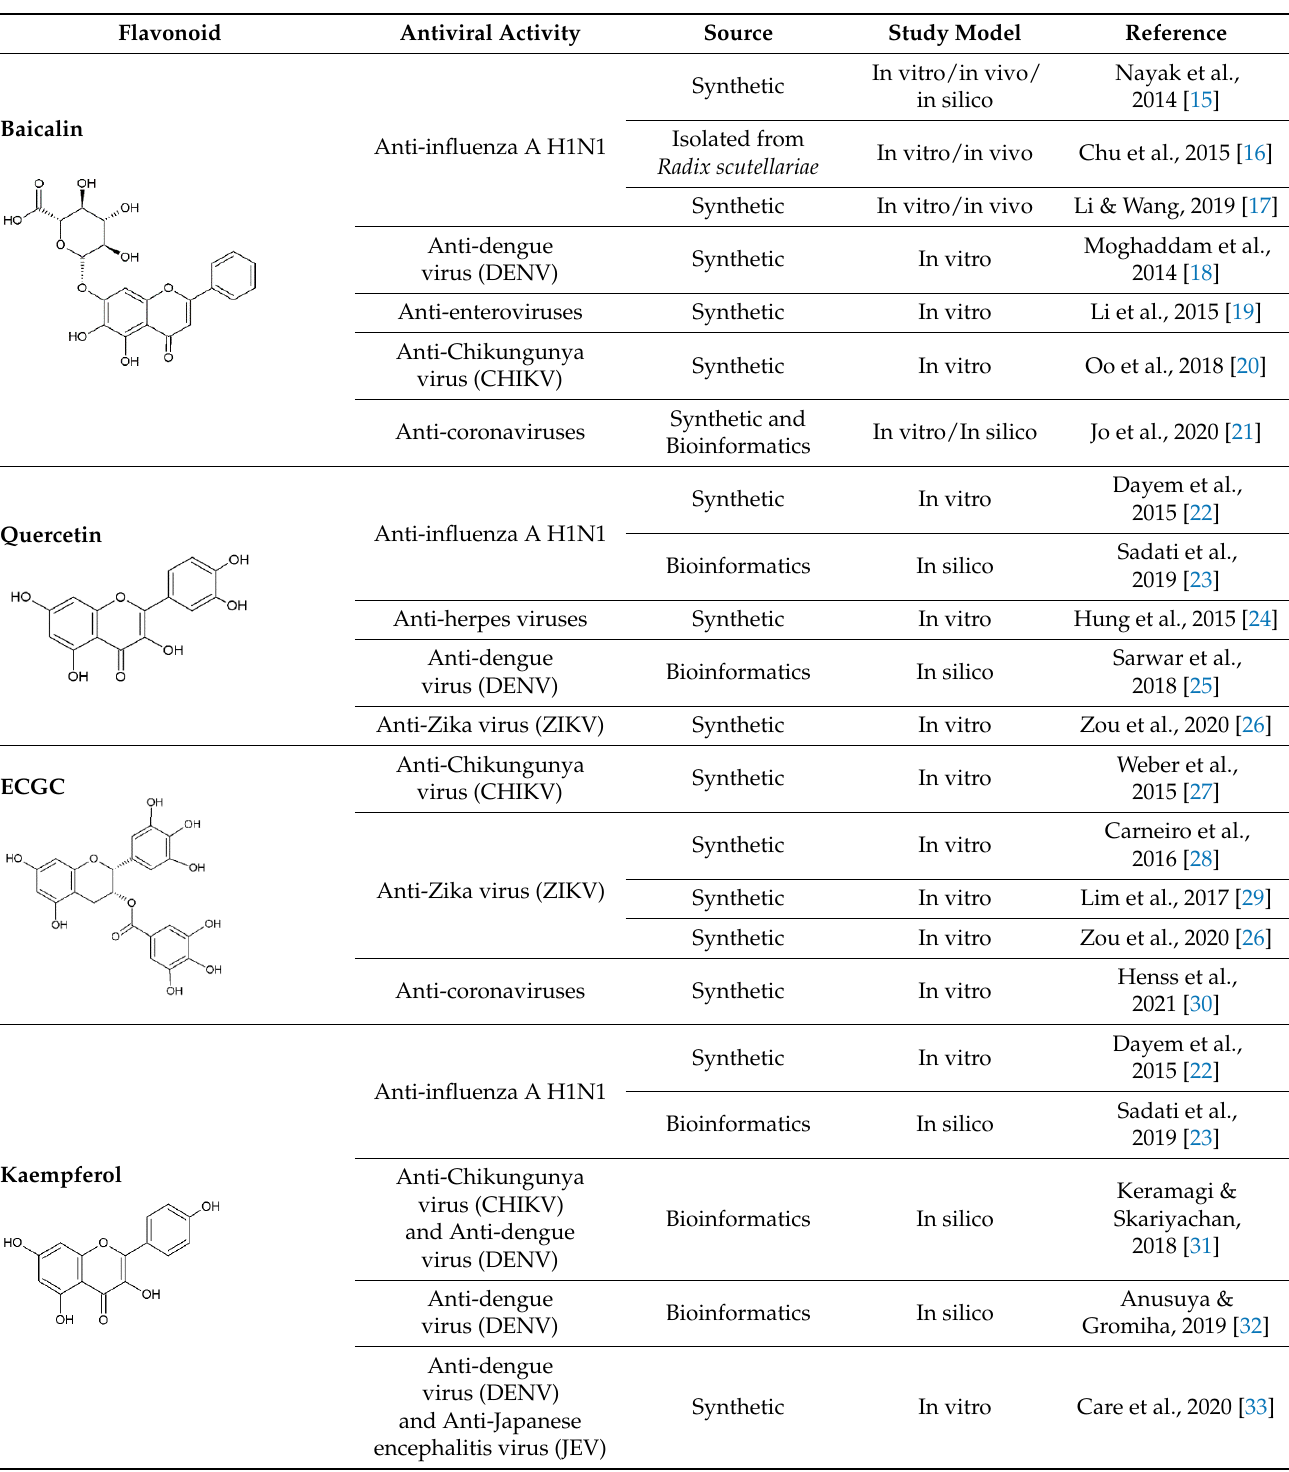
Table 1. Summary of the antiviral activities of the flavonoids most cited in the studies.